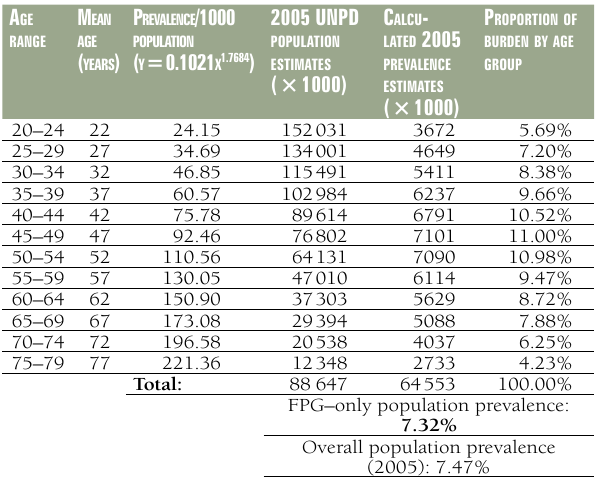
Table 17. Prevalence estimates for 2005 based on FPG–only studies